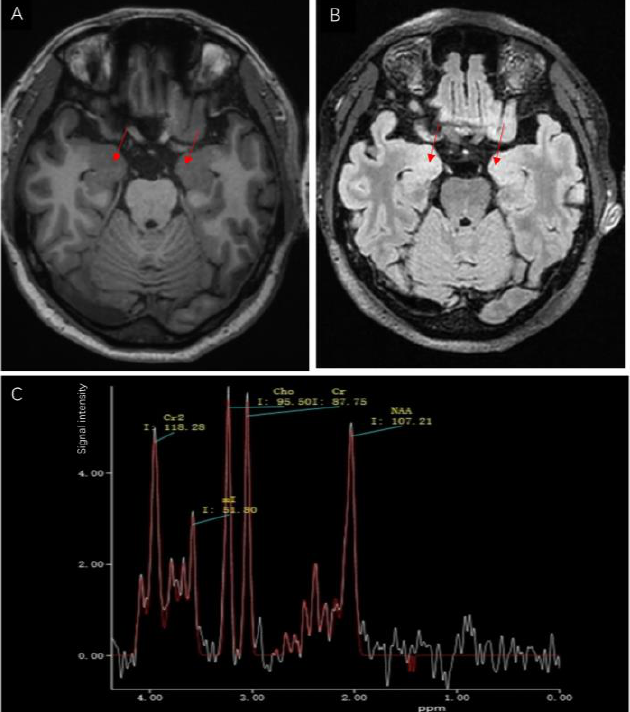
Figure 1. ( A ) Axial T1 weighted magnetic resonance images of the hippocampus showed no signif- icant abnormalities in the bilateral hippocampus (red arrow). ( B ) Axial fluid-attenuated inversion recovery (FLAIR) showed no significant abnormalities in the bilateral hippocampus (red arrow). ( C ) Magnetic resonance spectroscopy image showed a decreased NAA/Cho + Cr ratio (1.22/(1.09 + 1.00) = 0.58) in the left hippocampus.